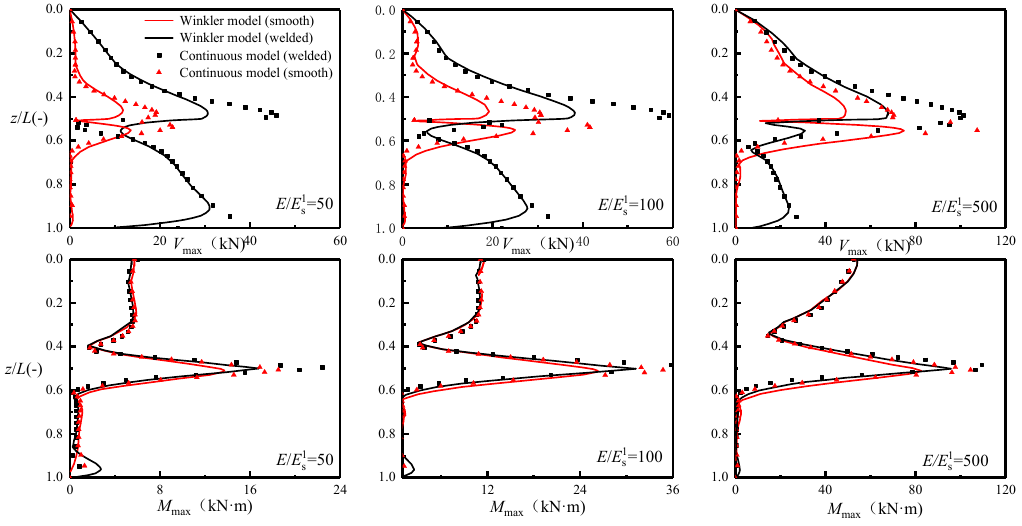
Figure 15. BDWF-based FEM results compared to the continuous model (reproduced from Álamo et al. (2018) [161]).